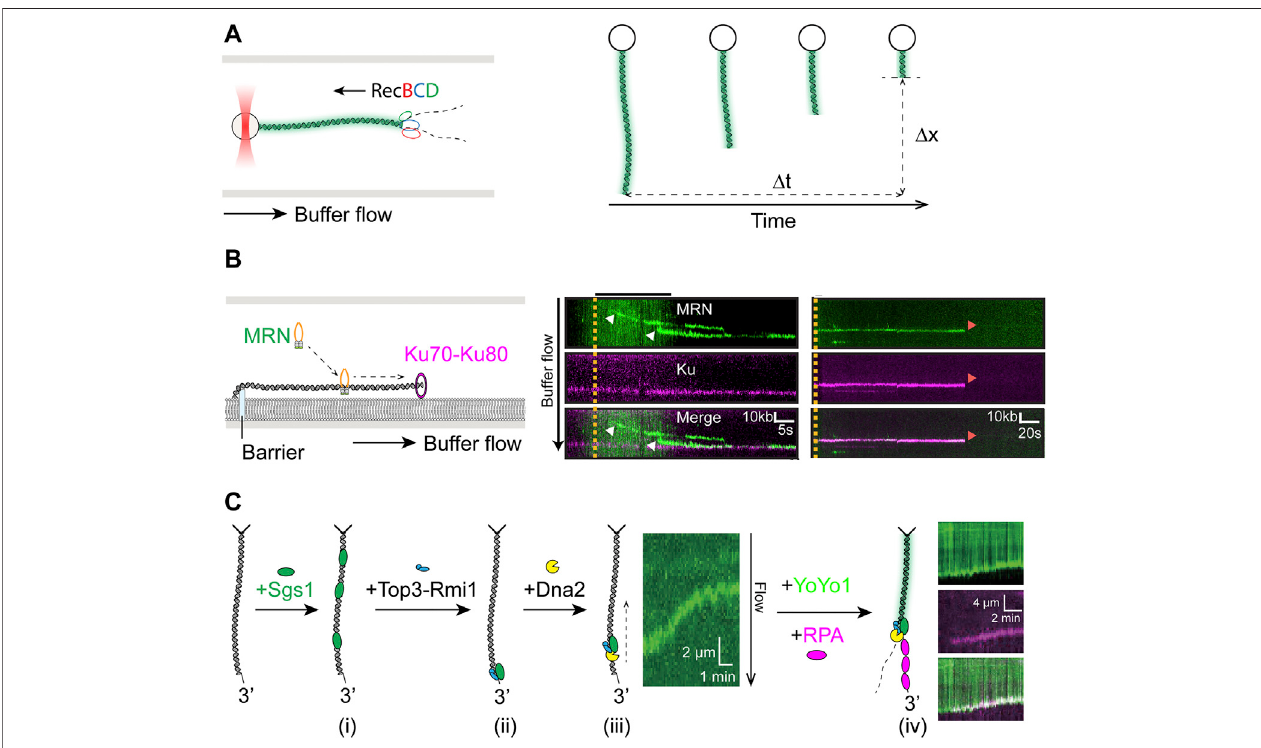
FIGURE3| Single-moleculestudiesofresectioninHR. (A)Left: SchematicsofunlabeledRecBCDresectingYOYO1-stainedDNAattachedtoanopticallytrapped bead and extended by hydrodynamic fl ow. Right: Velocity ( Δ x / Δ t ) and processivity of RecBCD resection could be measured by quantifying shortening of YOYO1 tract ( Δ x ) over time ( Δ t ). (B) Left: Schematics of fl uorescently labeled MRN binding to and sliding on single-tethered dsDNA, with end-bound Ku, in a single-tethered DNA curtain assay. Right: Kymographs showing the Mre11-dependent nucleolytic reaction leading to MRN and Ku release from DNA. White arrows indicate MRN binding.RedarrowsindicatedissociationofbothMRNandKu.Adapted from(Myler etal.,2017). (C) Sgs1boundrandomlytosingle-tethered dsDNAinDNAcurtain (i) , butwastargetedtothefreeendsinthepresenceofTop3-Rmi1 (ii) .Translocation(greentractinkymograph)bySgs1-Top3-Rmicomplexwasonlyactivatedbyaddition of Dna2 (iii) . End resection required further addition of RPA as evident by the shortening of YOYO1-staining of dsDNA accompanied by increase of fl uorescence RPA signal at the DNA end (iv) . Adapted from Xue et al. (2019b).